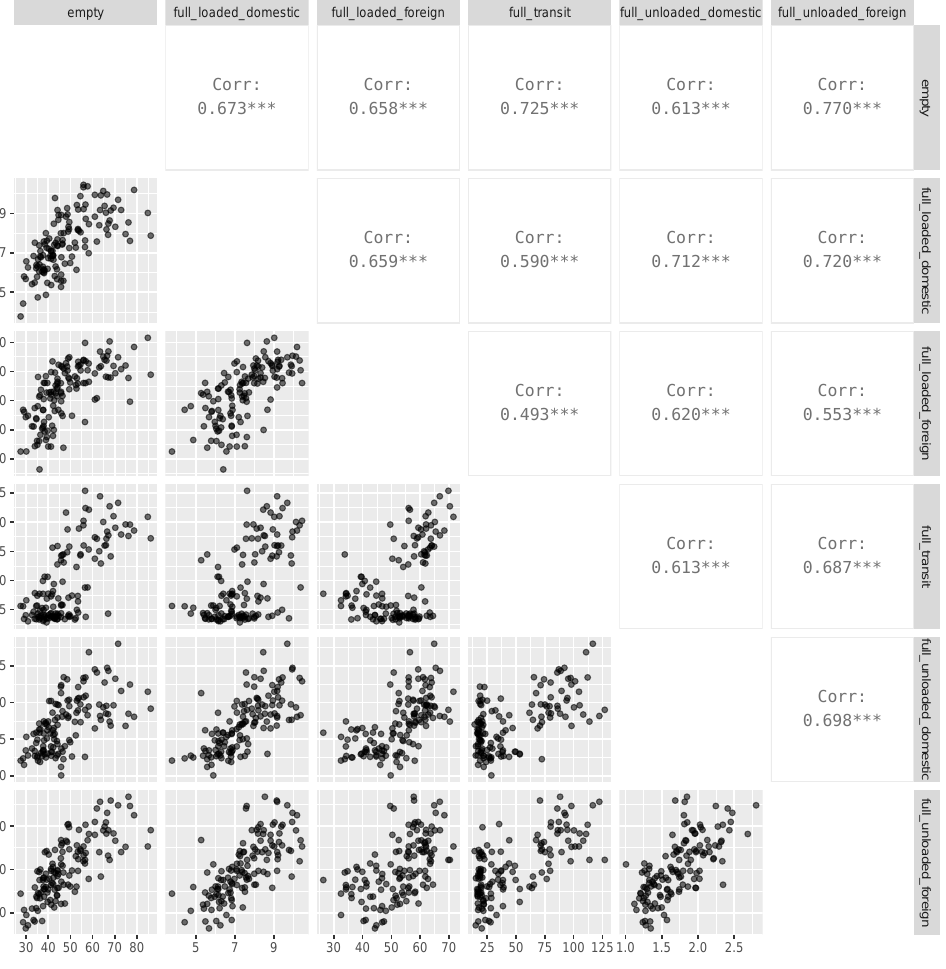
Figure 3. Pairwise scatter plots of the container traffic volume data. Correlation coefficients are marked with *** if the p -value of them being zero is less than